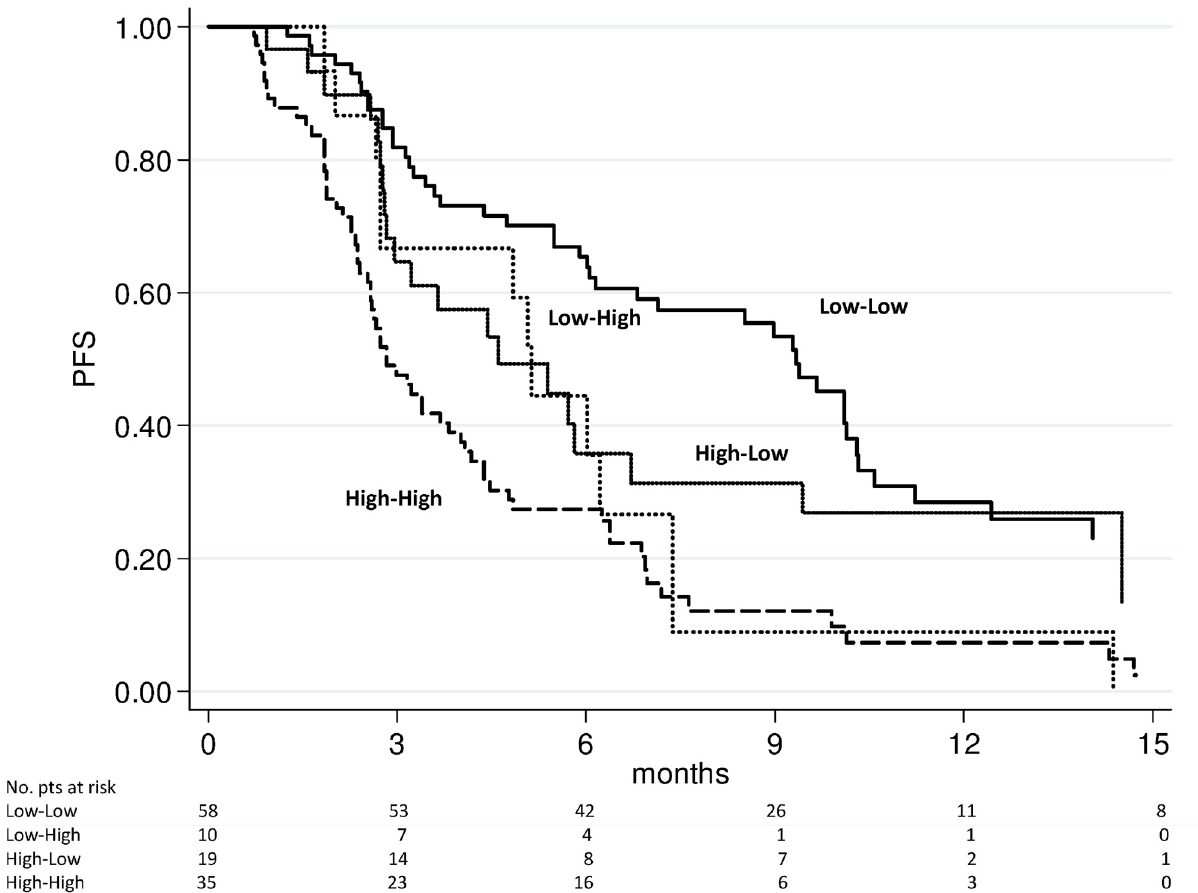
Fig 4. Progression-free survival according to pre-therapy and follow-up NLR at 12 weeks of enzalutamide treatment.